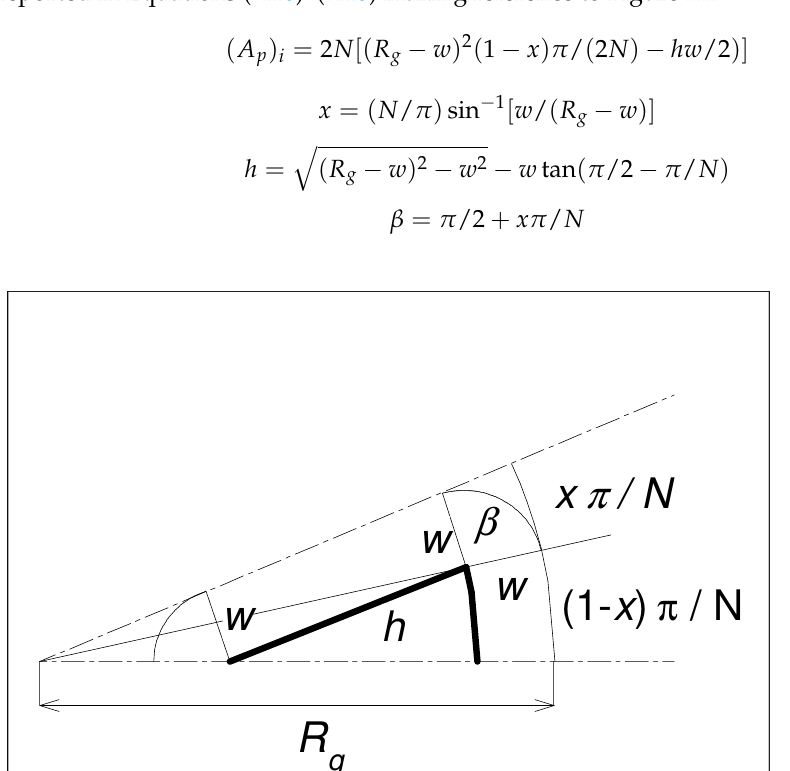
Figure A1. Triangular port